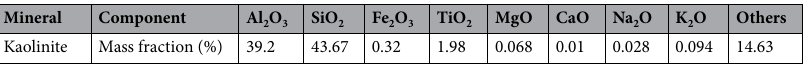
Table 1. The oxidic composition of